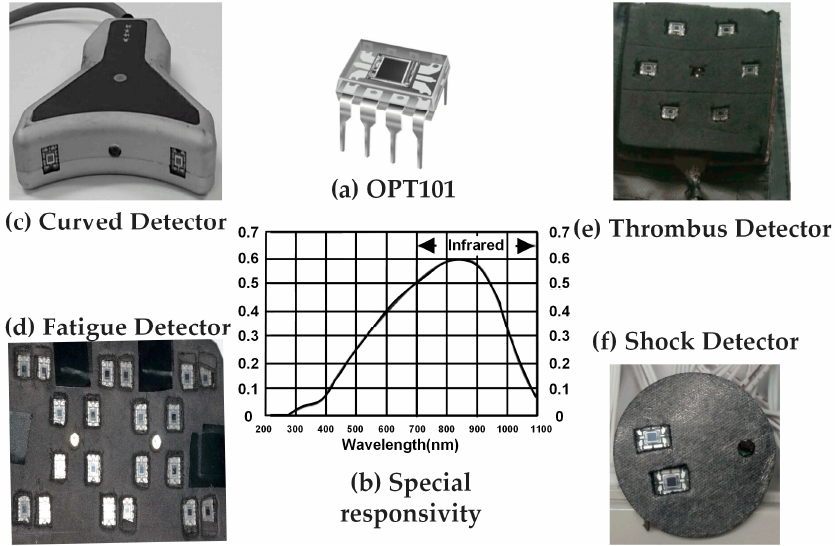
Figure 1. ( a ) OPT101 detector; ( b ) responsivity along with wavelength of OPT101; ( c – f ) the probe designs with the detector embedded according to different applications.